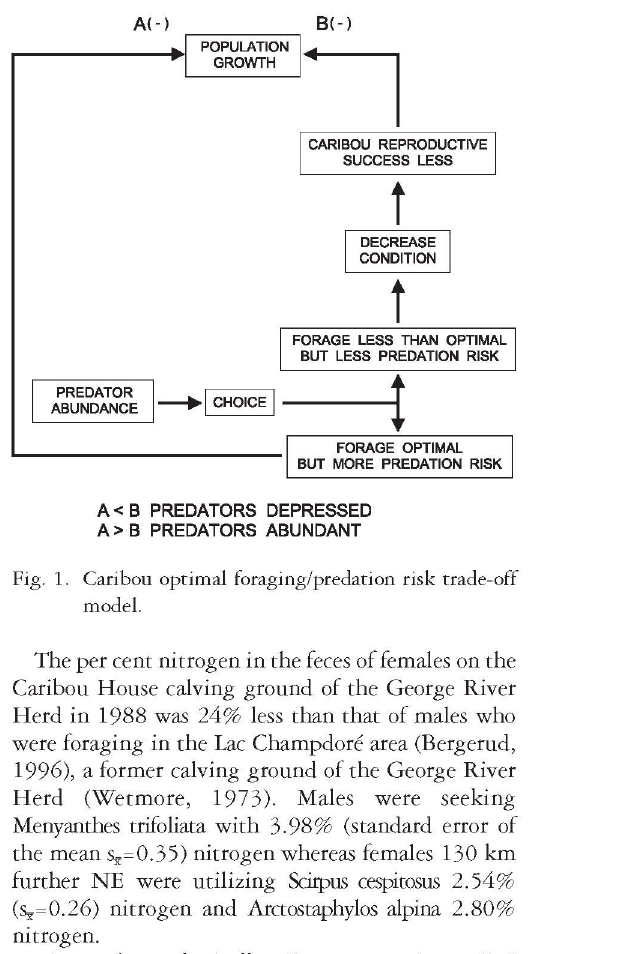
Fig. 1. Caribou optimal foraging/predation risk trade-off